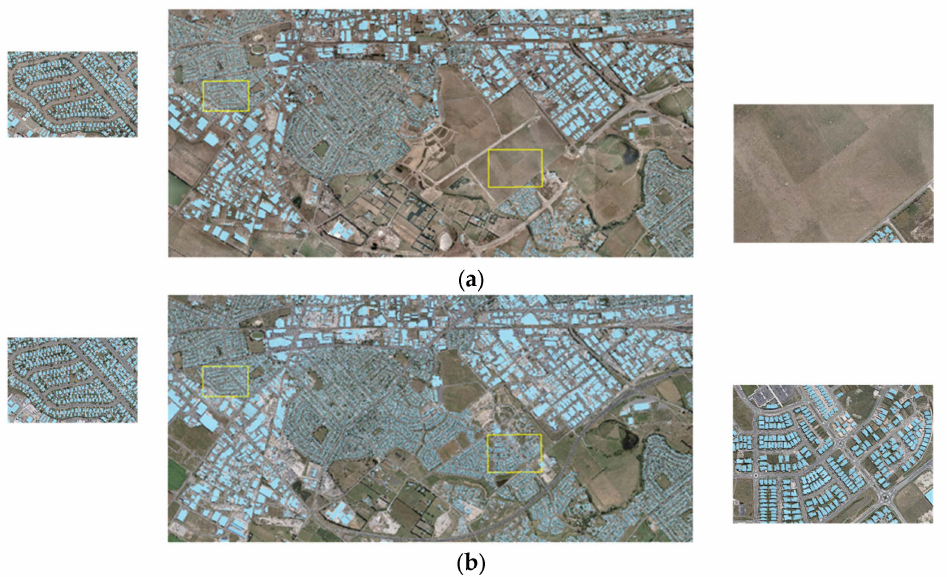
Figure 4. Wuhan University building change detection dataset, ( a , b ) show the images and the corresponding building labels for 2012 and 2016,